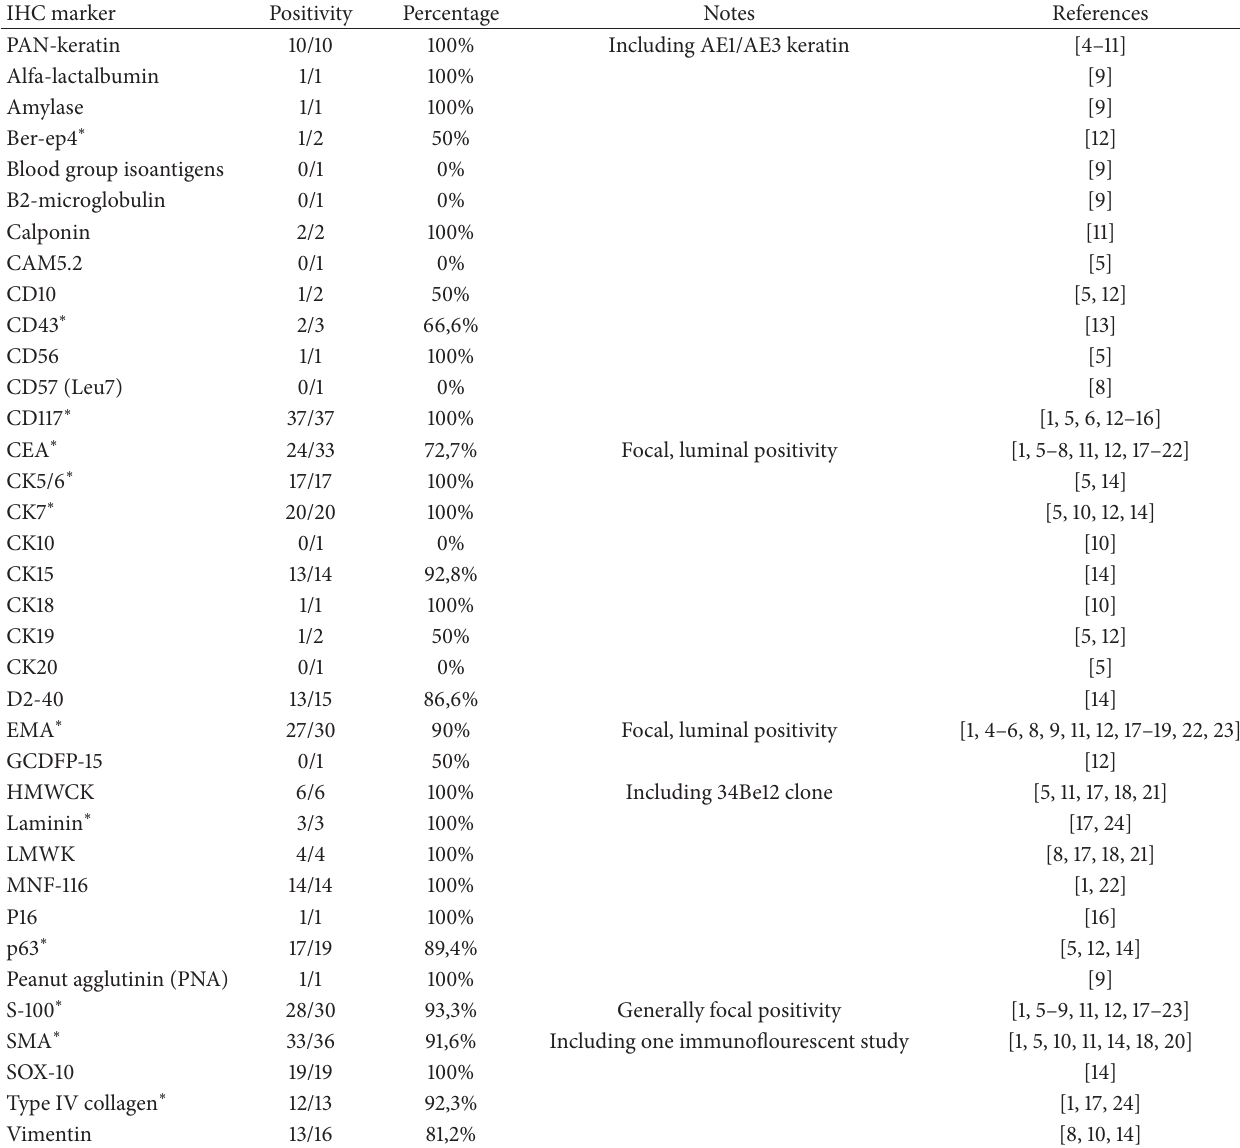
Table 1: Summary of immunohistochemical studies in the literature &